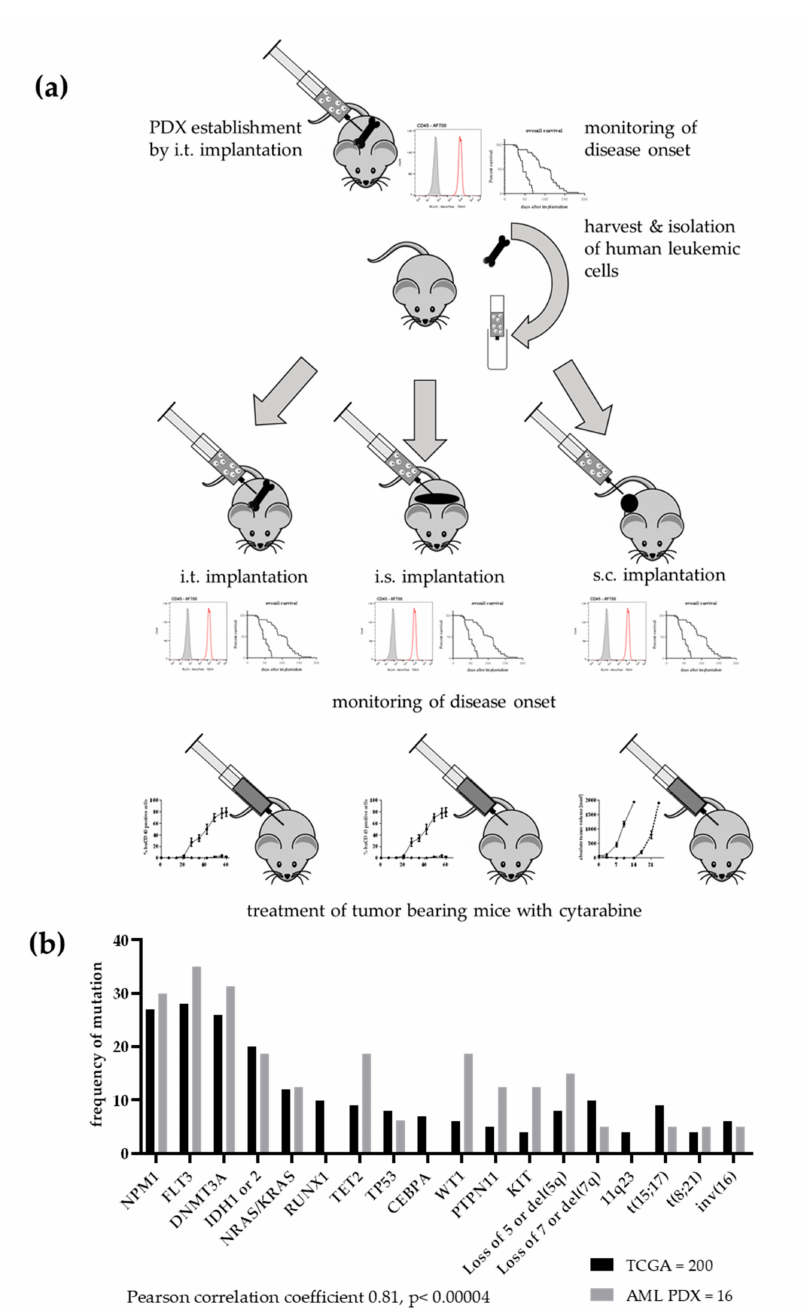
Figure 1. Establishment of a patient-derived xenograft panel of 20 acute leukaemia models. ( a ) Implantation scheme over several passages. Patient blasts were implanted into the bone marrow of NSG mice. When disease onset was observed by detection of human cells in peripheral blood and deterioration of overall condition, mice were sacrificed and cells from bone marrow and spleen harvested. After a mouse cell depletion human leukaemic cells were re-implanted into the bone marrow of recipient mice. This procedure was repeated until stable growth was observed. Subsequently, the PDX leukaemic cells were implanted into the bone marrow, in the spleen or subcutaneously into NSG mice. The monitoring of disease onset was performed as described before. Additionally, the antitumoral activity of cytarabine was evaluated in all three settings in four di ff erent PDX models. ( b ) For 16 models, mutational data were available. The comparison with TCGA data revealed a highly significant correlation between the two data sets. Mutational data were either acquired based on WES or